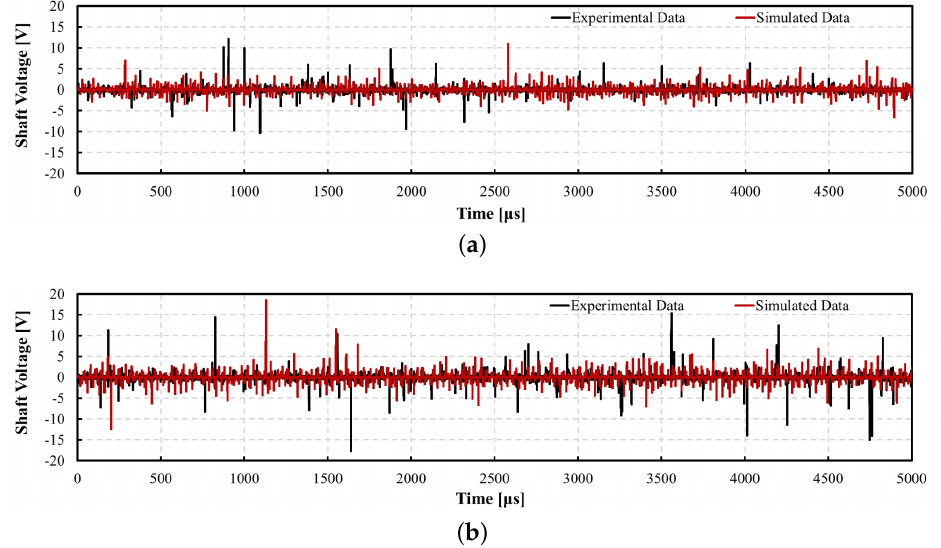
Figure 18. Shaft voltage obtained from experiments and bearing discharge model at 3000 rpm: ( a ) 360 V; ( b ) 600